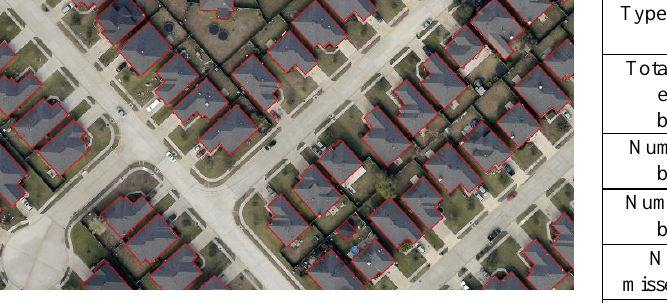
Figure 9 Extracted Building Outlines in Open Area